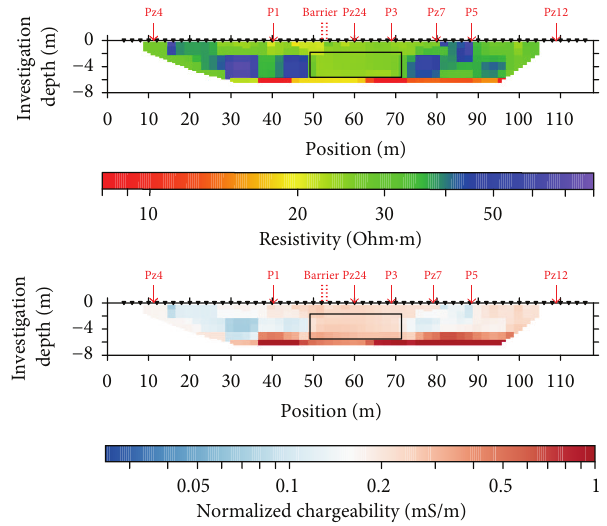
Figure 3: Resistivity and normalized chargeability sections across the plume for the permanent electrical profile, on 6th March 2014. The black rectangle highlights a zone of lower resistivity and higher normalized chargeability.